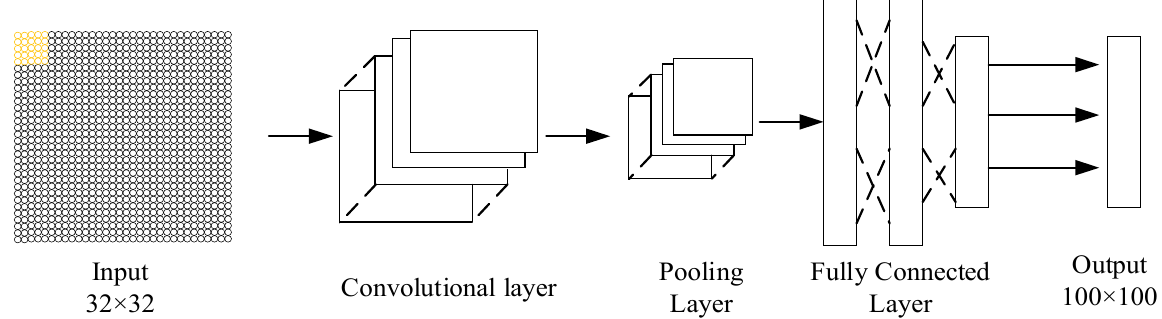
Figure 3. Convolutional neural network structure used in the constructing algorithm. The sensory field size in the network is 5 × 5, and the feature data are pooled in the pooling layer to perform a 2 × 2 pooling operation, and finally, a 100 × 100 regression value is obtained for imaging through the fully connected layer. The cost function is a quadratic cost function with following form: